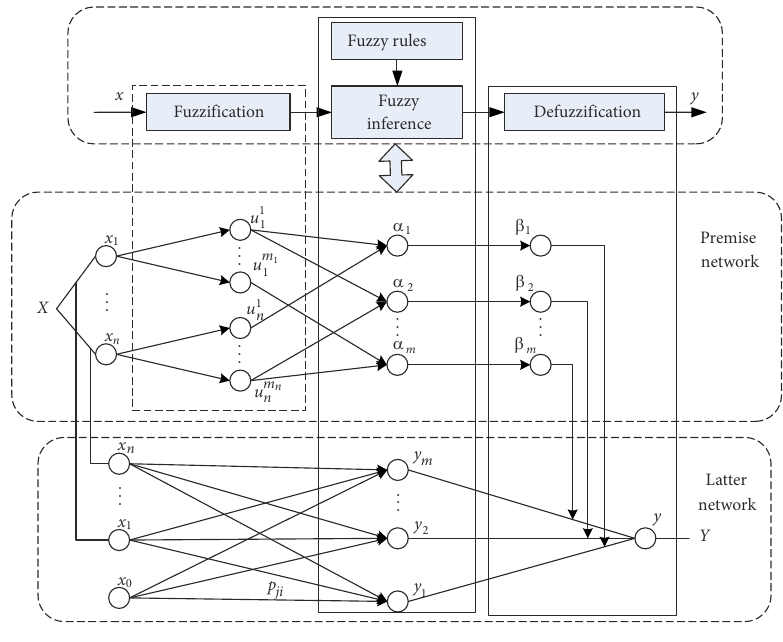
Figure 4. The system structure of a fuzzy neural network based on T–S